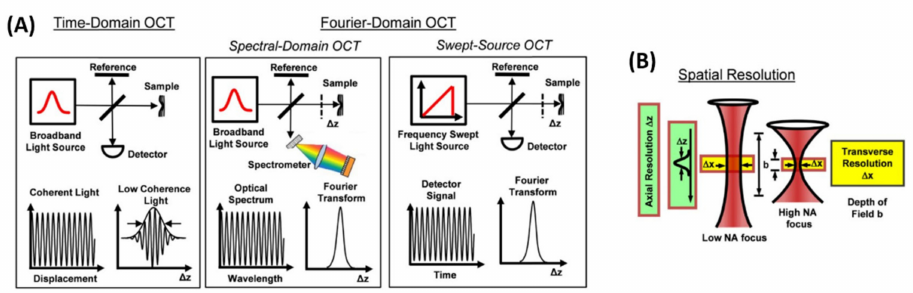
Figure 4. ( A ) Key concepts of OCT, including TD-OCT, SD-OCT, and SS-OCT detection; ( B ) Axial and lateral image resolution and depth of field; Adapted with permission from ref.